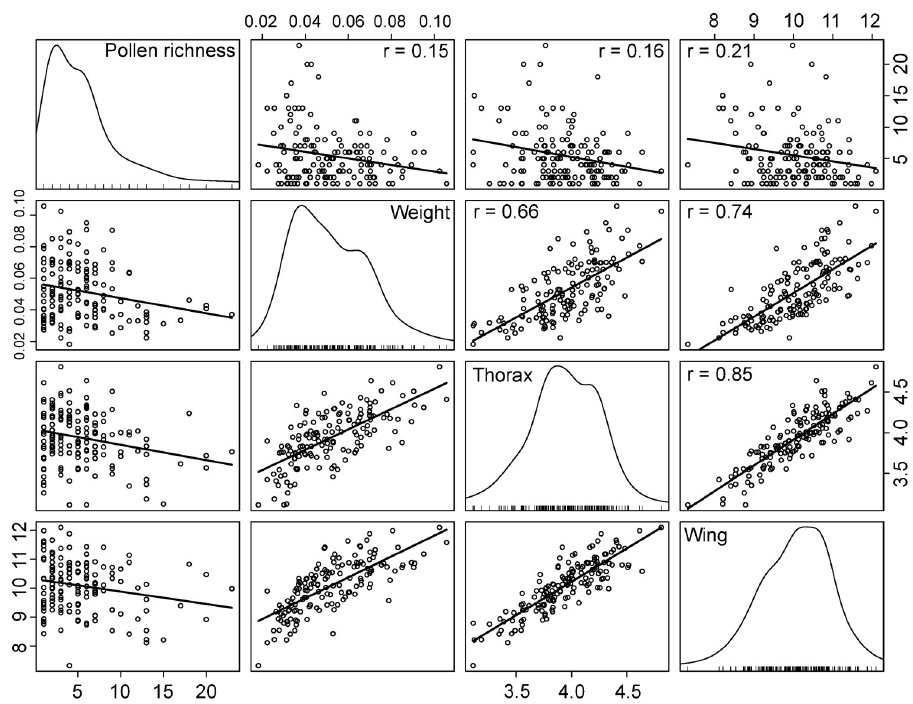
Fig 5. Matrix of correlation between pollen richness, weight, thorax width and wing length of 205 Bombus impatiens workers captured from 80 colonies placed on 20 sites during the summer of 2016 in Southern Que´bec, Canada.